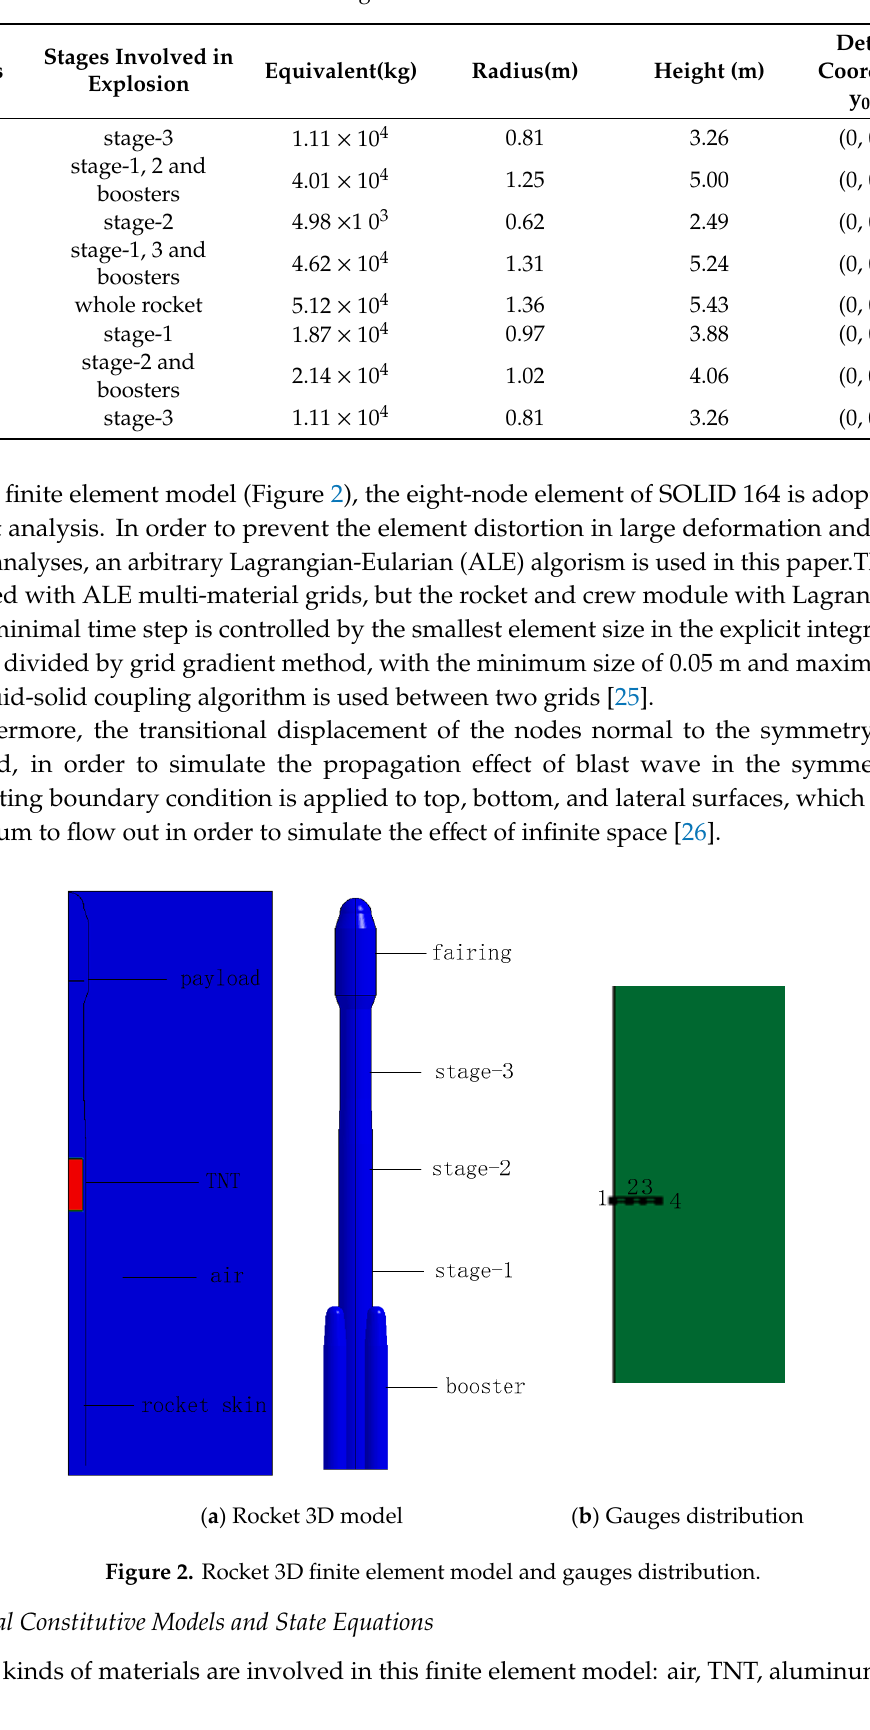
Table 6. Parameters setting of TNT model in numerical simulation.